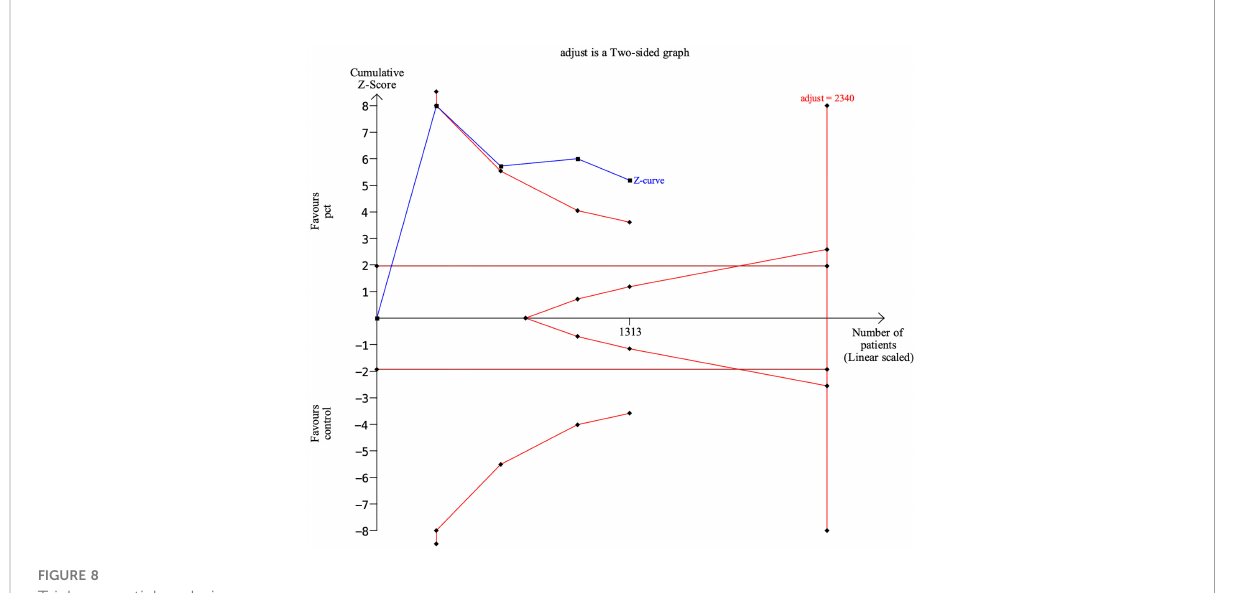
FIGURE 8 Trial sequential